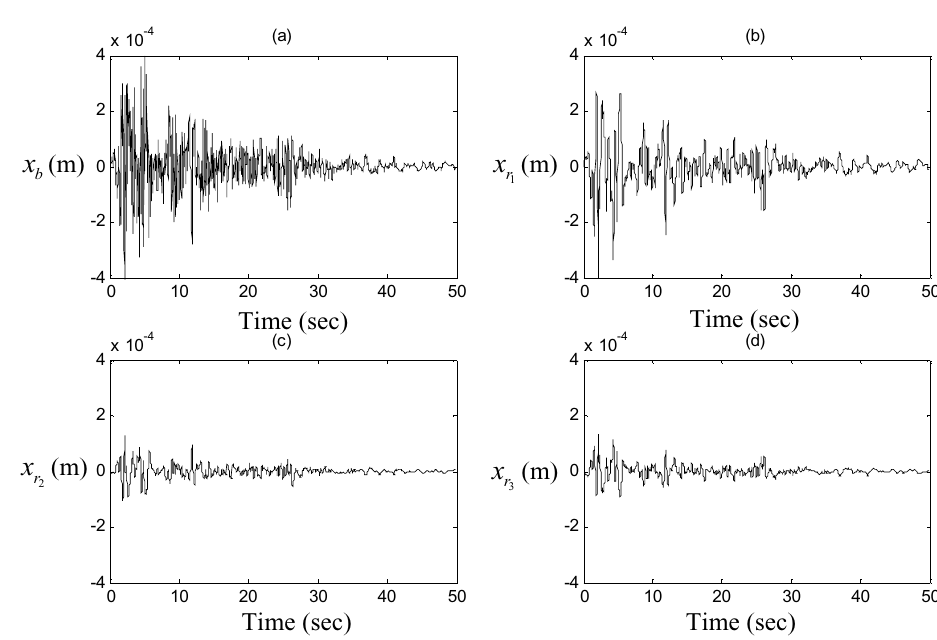
Fig.8. Relative displacement simulations of passive controlled system by confinement with the SMSDAapproach. (a) Passive element x r 1 = x p ; (b) First mass x r 2 = x 1 ; (c) Second mass x r 3 = x 2 − x 1 ; (d) Third mass x r 4 = x 3 − x 2